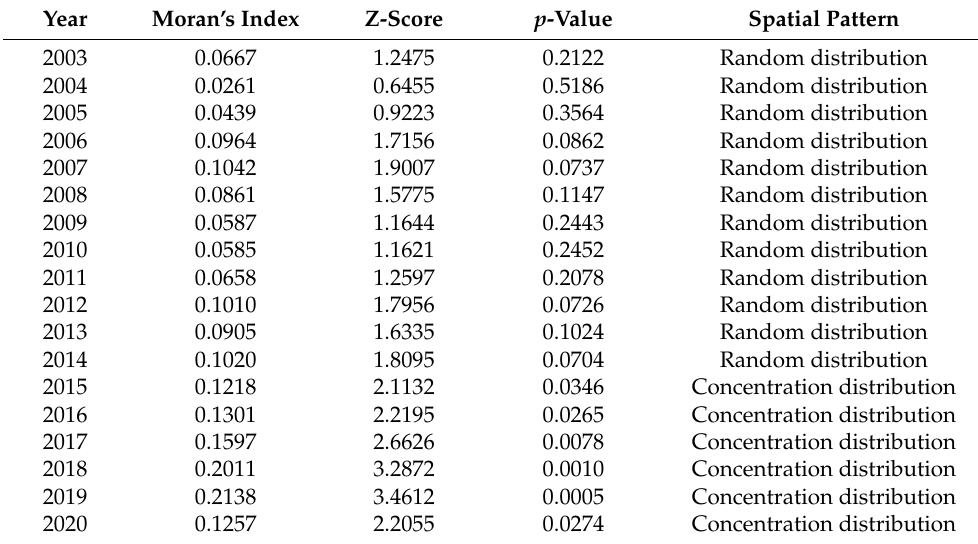
Table 3. Global Moran’s I index of